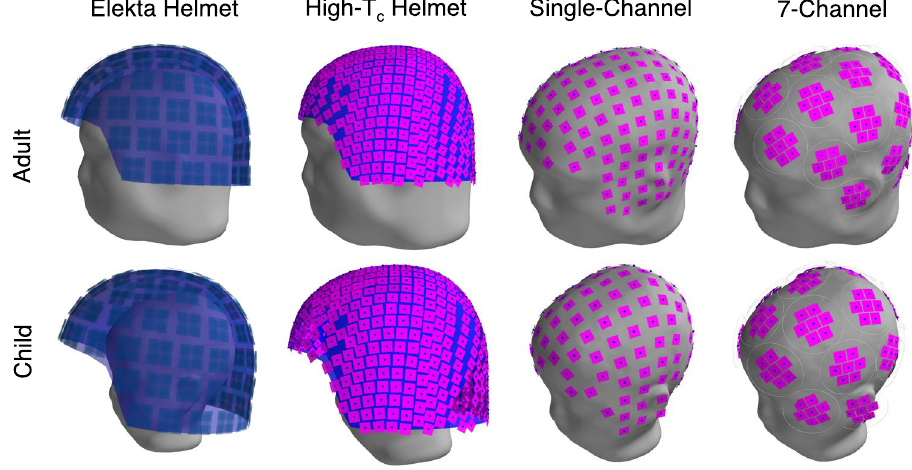
Figure 5. The sensor positions (pink with a blue dot in the center) in all layouts for sampling the child and adult brains are shown. The helmet surfaces in the Elekta and high- T c helmet layouts are shown in